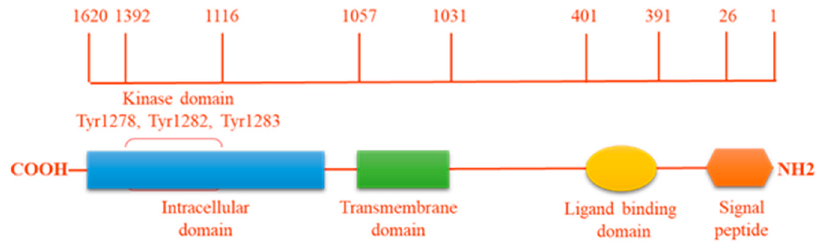
Figure 1. ALK protein structure. The intracellular tyrosine kinase domain harbors the 3 tyrosine motif Tyr1278, Tyr1282, Tyr1283, which represents the major auto-phosphorylation site regulating kinase activity .